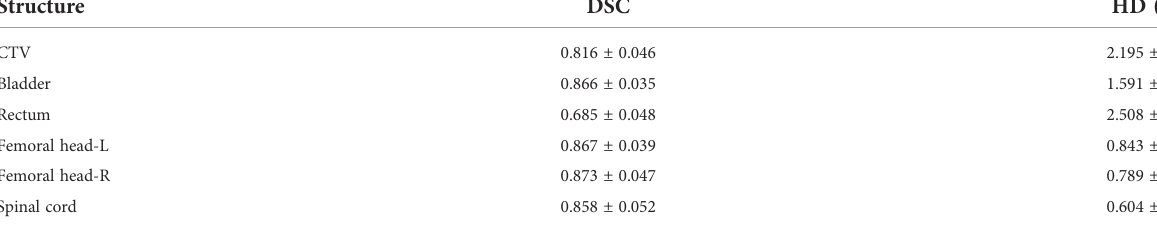
TABLE 2 DSC and HD value of CTV and OARs with an atlas library size of 20. Structure